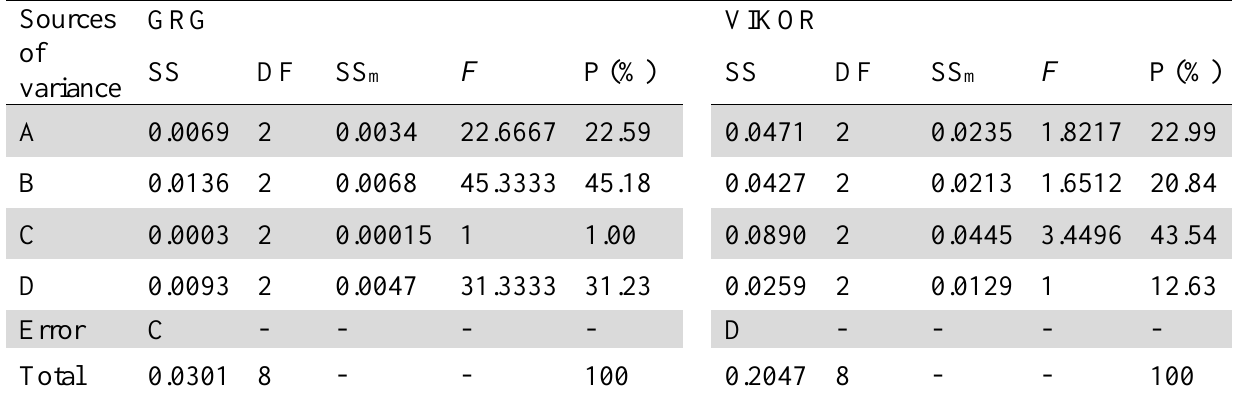
Results of ANOVA for GRG, and VIKOR